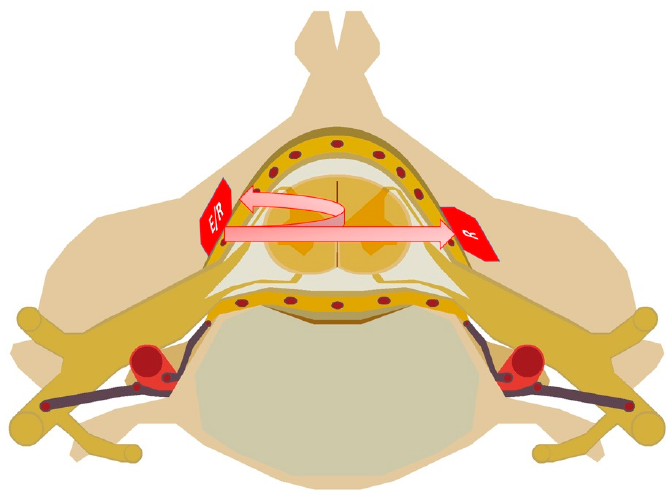
Figure 3. Illustration of the optical imaging process with custom